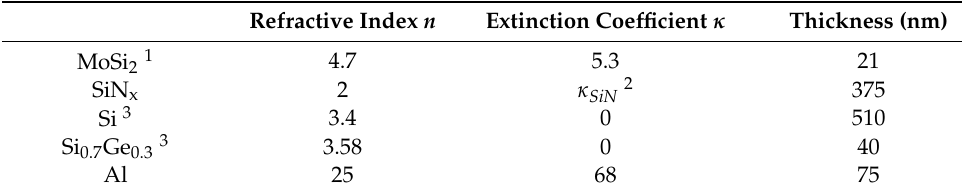
Table 2. The film optical parameters of the infrared-absorption structure.